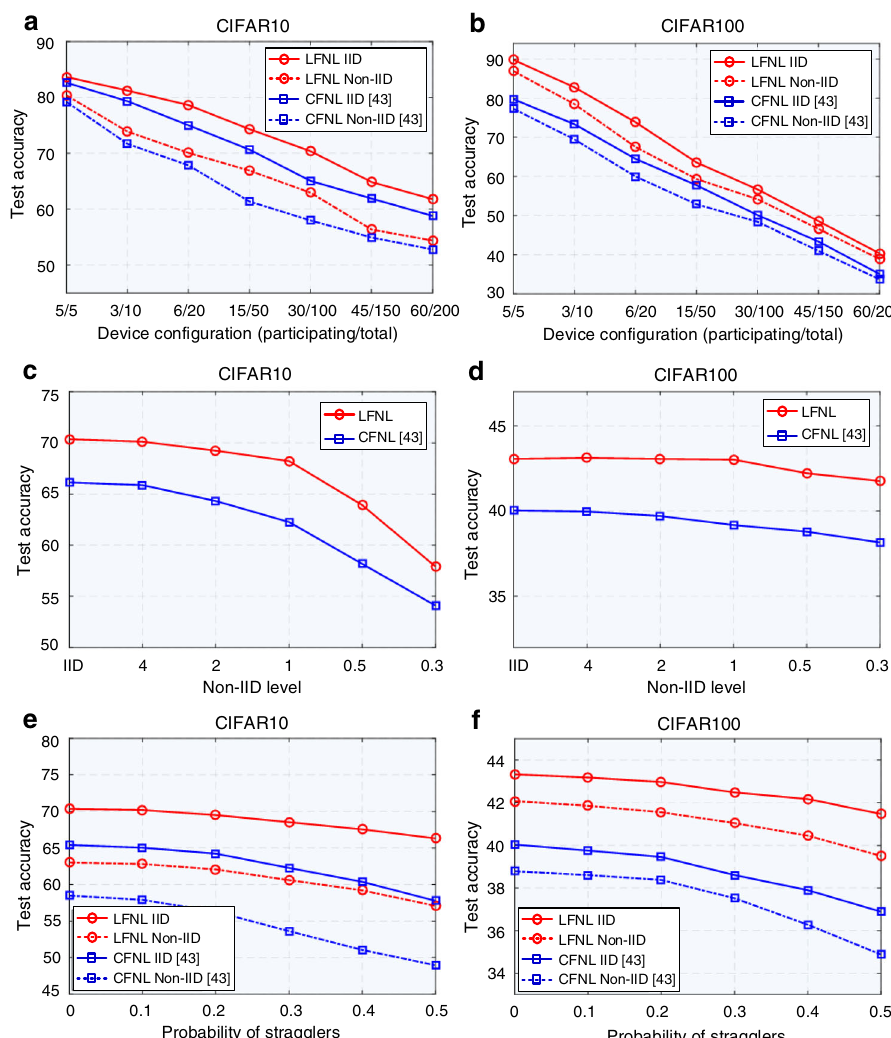
Fig. 6 | Classi fi cation accuracy evaluation on CIFAR10 and CIFAR100 datasets. a , b Performance evaluation of LFNL vs CFNL under different device con fi gura- tions. c , d Impact of the non-IID data factor on the classi fi cation accuracy of LFNL vs CFNL when the training dataset is divided among 100 devices and 30 devices